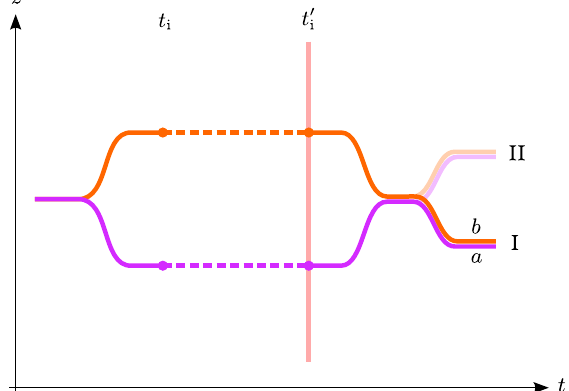
FIG. 10. Central trajectories for a guided interferometer in the laboratory frame. Performing a doubly differential measurement for different initialization times has a number of practical advantages and directly reveals the differences of gravitational time dilation between the two branches.